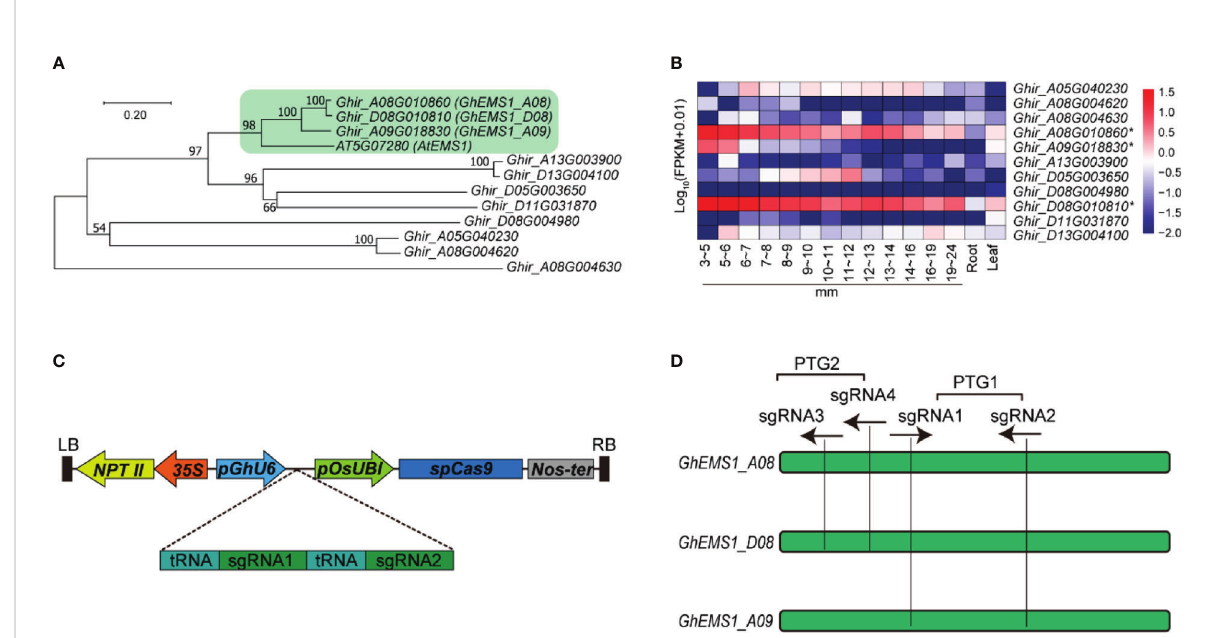
FIGURE 1 Creation of Gh EMS1 genes mutants by using CRISPR/Cas9. (A) A phylogenetic tree for EMS1 genes in Gossypium hirsutum and AtEMS1 was constructed using the neighbor-joining method in MEGA 10.1.8 followed by bootstrapping with 1,000 replicates; (B) Expression pro fi les of GhEMS1 genes in fl ower buds of different lengths (3~5 mm, 5~6 mm, 6~7 mm, 7~8 mm, 8~9 mm, 9~10 mm, 10~11 mm, 11~12 mm, 12~13